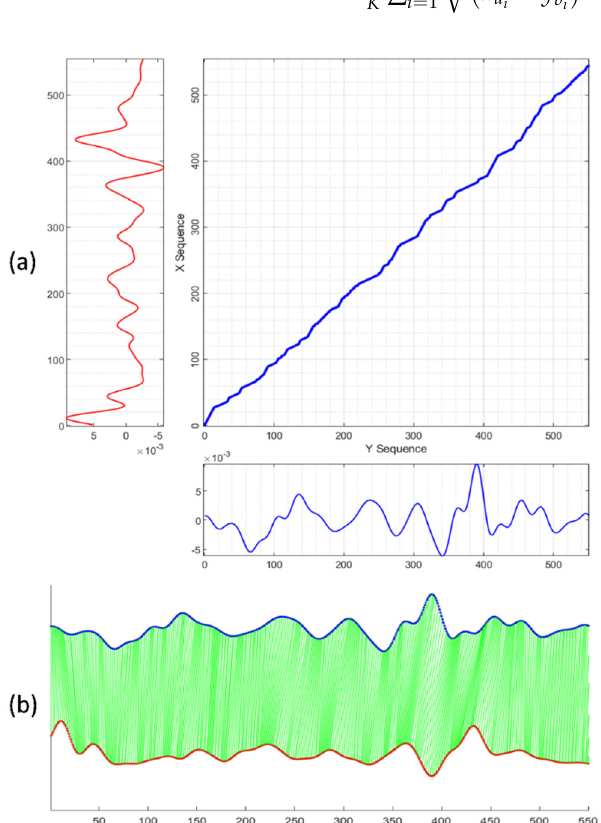
Figure 6. Illustration of the DTW alignment of two signal sequences: ( a ) Matrix grid view of DTW alignment; ( b ) Point-to-point mapping of DTW alignment.